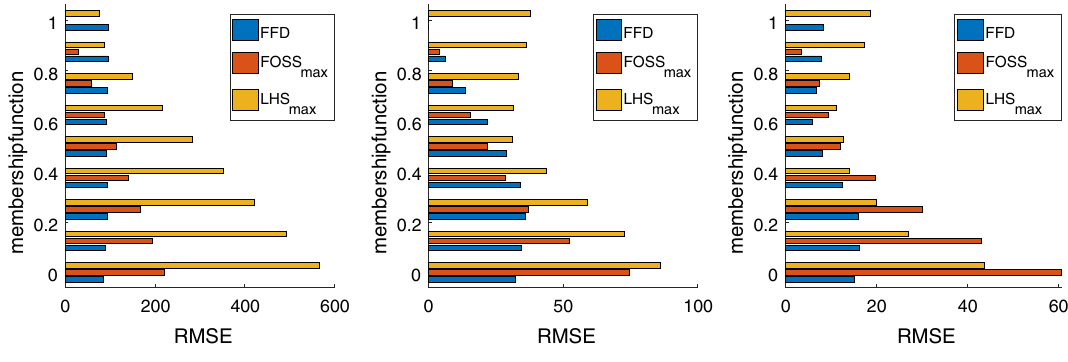
Fig. 15 Branin function: maximum RMSE on 𝛼 -cuts for a RBF surrogate with 4 (left), 9 (center), and 16 (right) sampling points